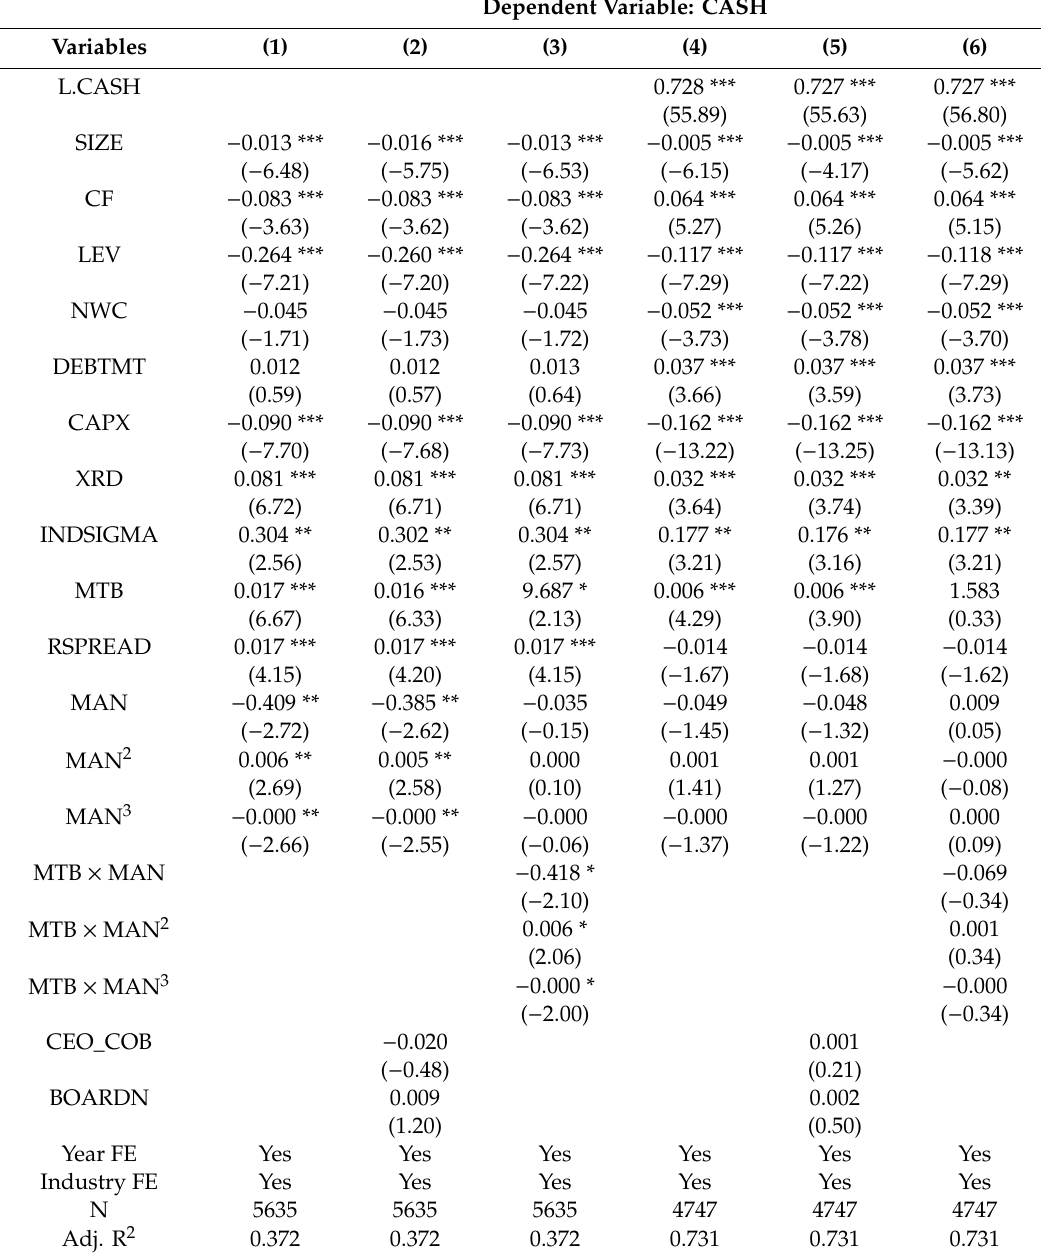
Table 8. Regressions of cash holdings on managerial ownership, controlling shareholder, and other firm